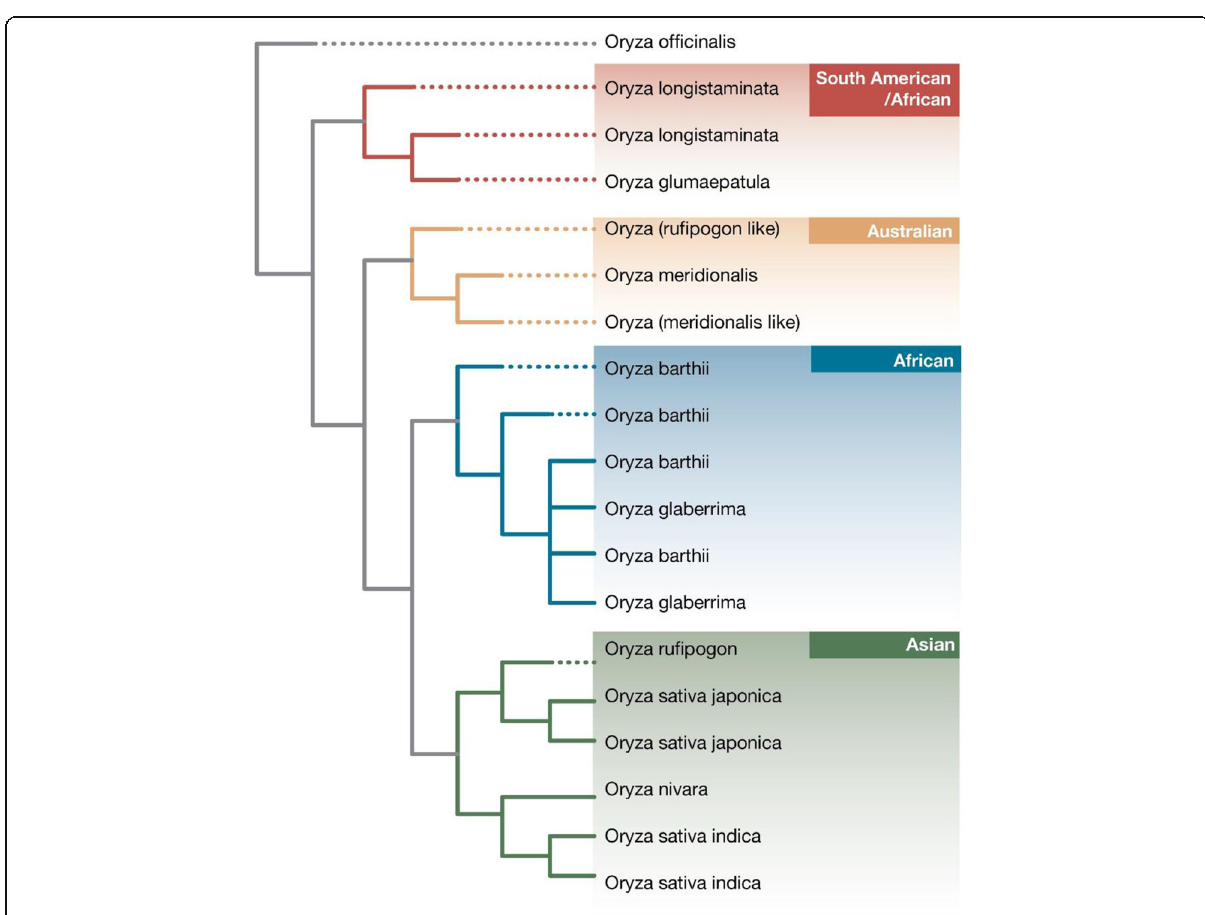
Fig. 1 Phylogenetic relationships between various Oryza AA genome group species based on whole chloroplast genome sequences. Shows the close genetic relationship between O. glaberrima and O.